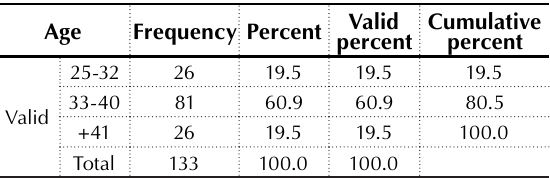
Table 1. Characteristics of respondents based on their age